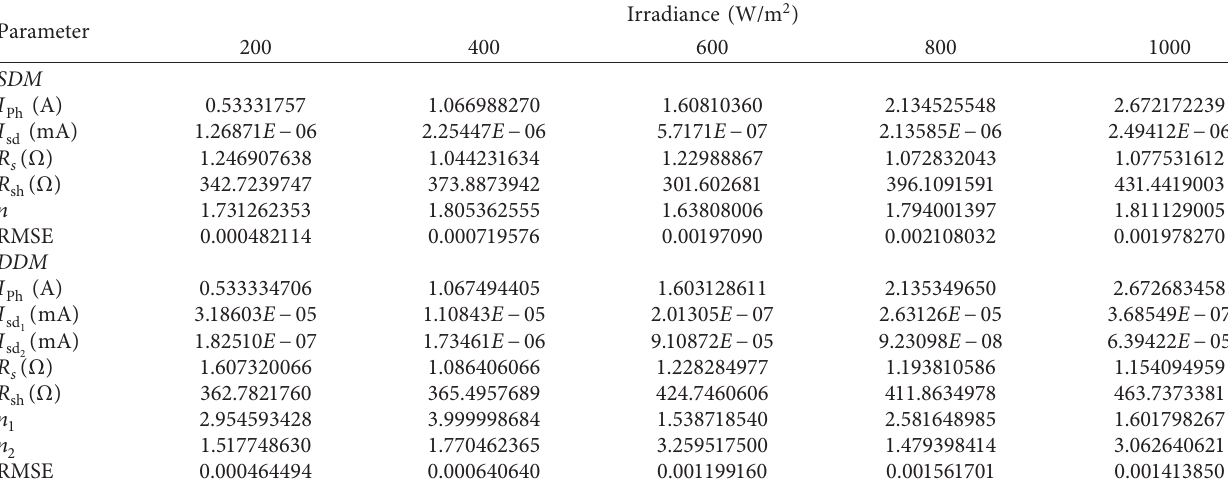
Table 10: Parameter estimates by MWOA for ST40 at different irradiances with a temperature of 25 ° C.